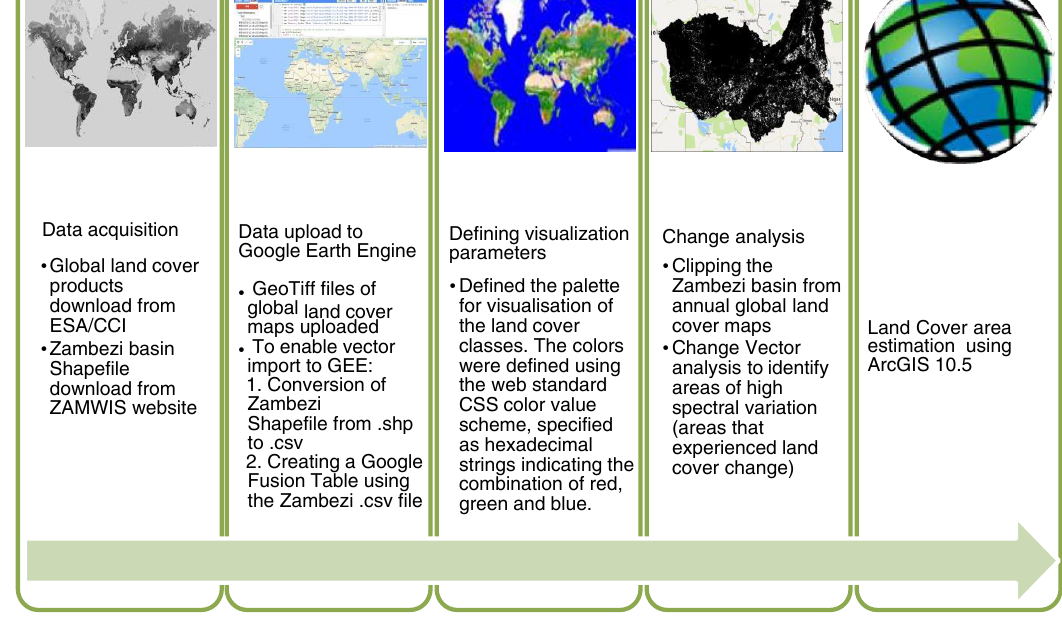
Figure 3. Methodological steps.